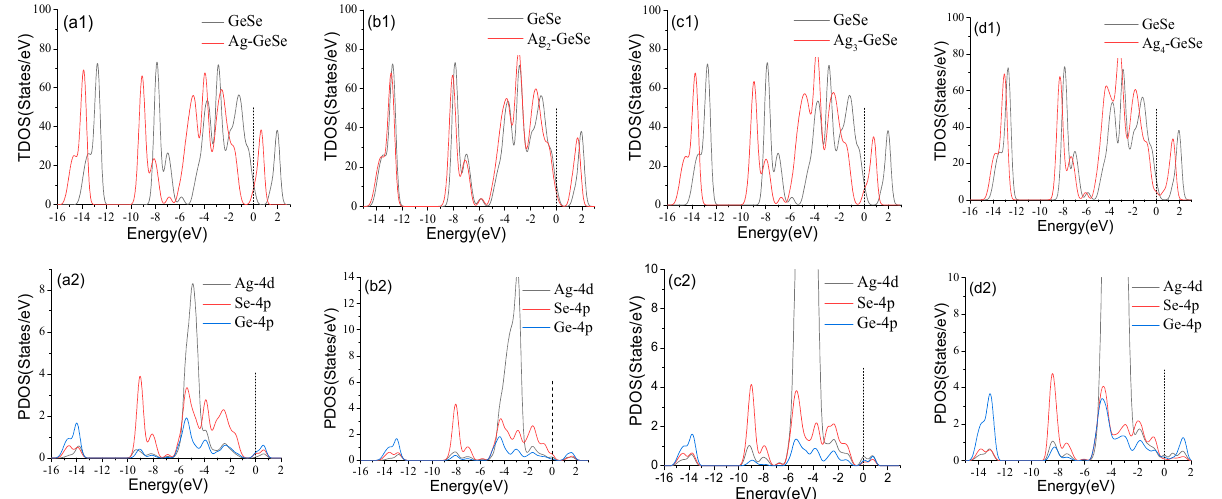
Figure 3. TDOS and PDOS before and after 1~4 Ag atoms doping on GeSe. ( a1 - a2 ) Ag-GeSe, ( b1 - b2 ) Ag 2 -GeSe, ( c1 - c2 ) Ag 3 -GeSe, ( d1 - d2 ) Ag 4 -GeSe.